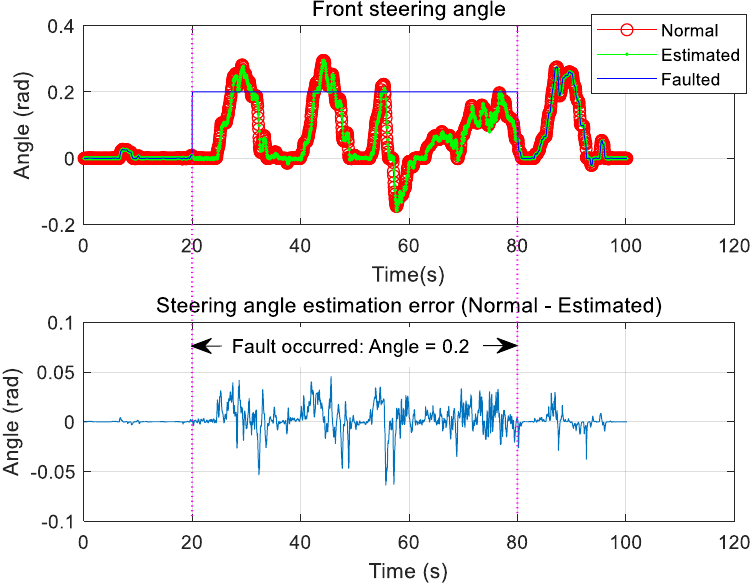
Figure 10. Type 2: Front steering angle sensor fault and estimation.